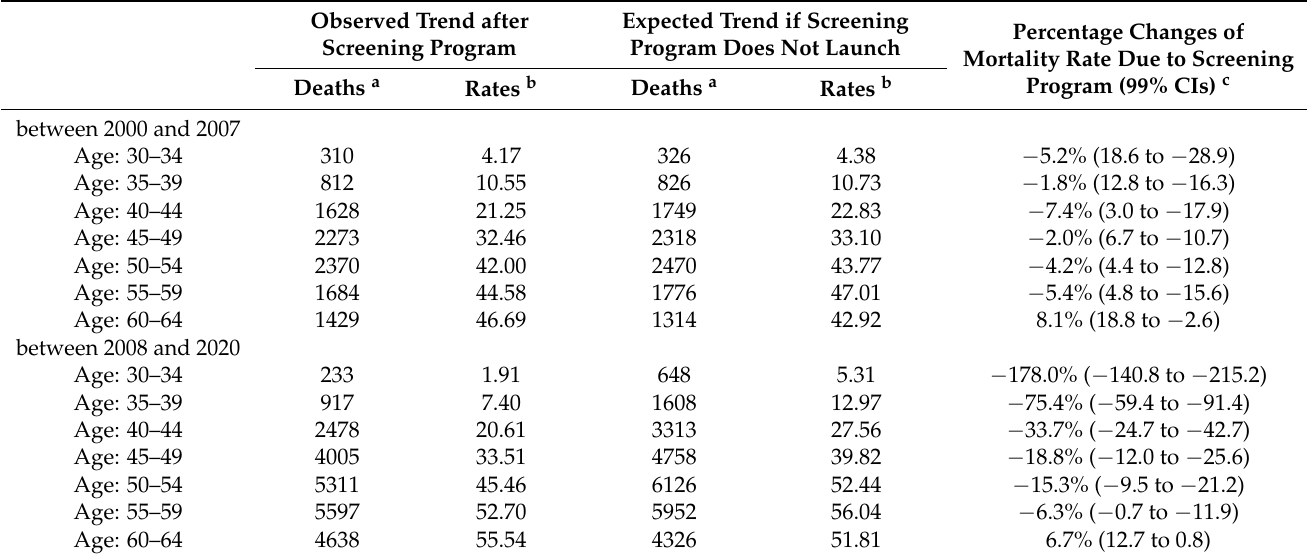
Table 2. Effects of the nationwide oral mucosal screening program on oral cancer mortality in Taiwanese men between 30 and 64 years